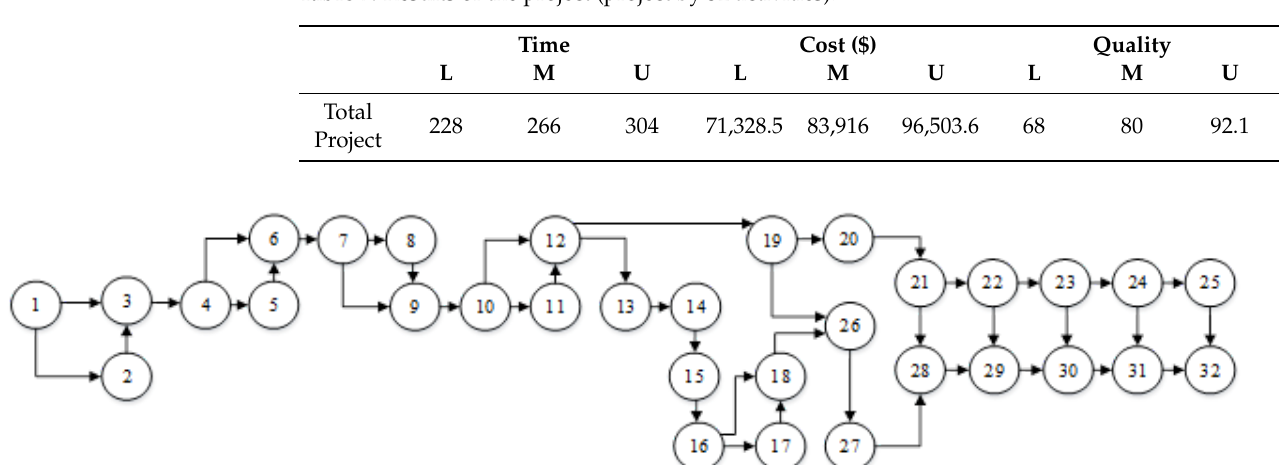
Table 5. Results of the project (project by 13 activities). Figure 4. Project critical path. Figure 4. Project critical path. Table 7. Results of the project (project by 32 activities).